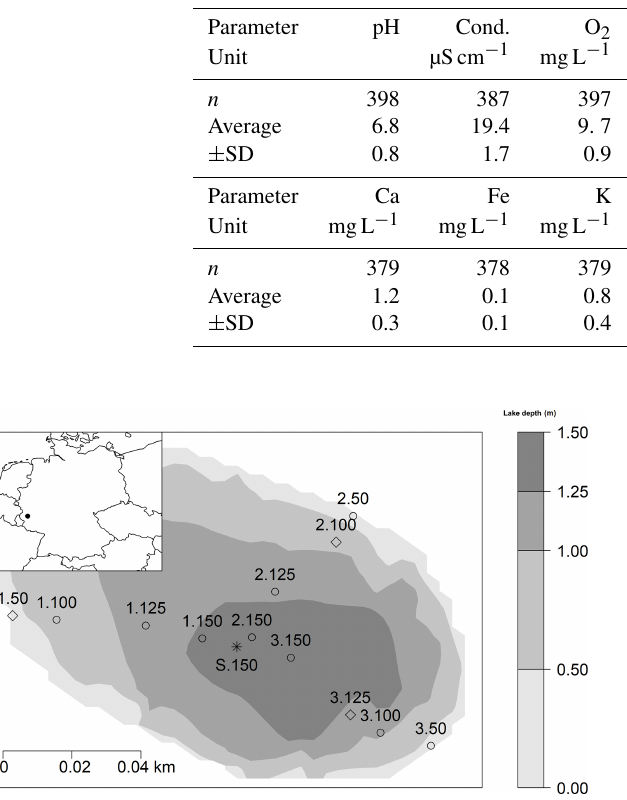
Figure 1. Location of the study area in Germany (black spot on the map top left) and 13 sampling sites within Lake Windsborn.